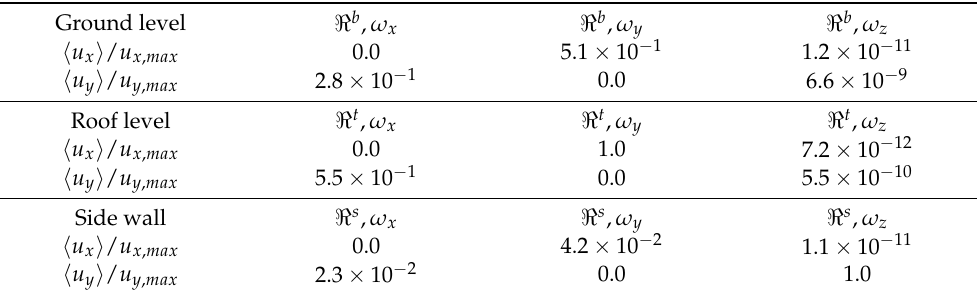
Table A1. Spatially averaged velocities for different vortex sheets, vorticity components and AR = 3. The normalisation constant is the maximum value for the entire set of vortex sheets.